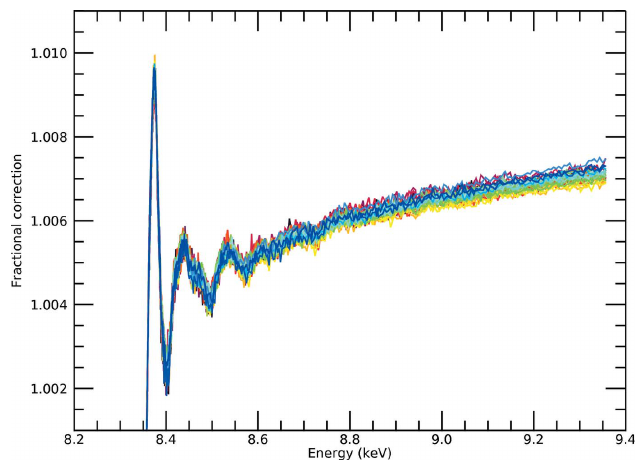
Figure 10 The combined effect of the second-order expansion of the expression (10) correction multiplied by the correction in expression (11) for the i -pr data set. Both corrections are small and well converged and the exact form of the exponential is clear, yet the neglect of the oscillatory component introduces a very minor change overall.